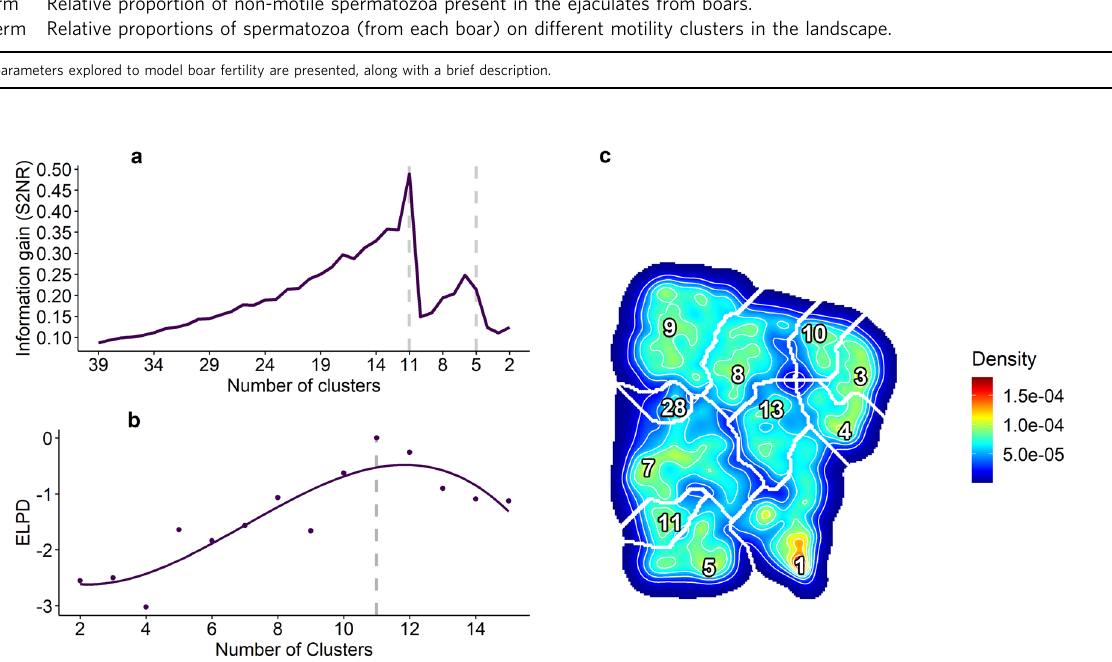
Fig. 6 Model selection based on sperm motility landscape con fi gurations. a Signal-to noise ratio (S2NR) as an heuristic of information gain, along the process of merging. The information generally increases along the merging process. However, there were some drops, that corresponded with signi fi cant changes in the hierarchical organisation of the landscape. b Leave-one out method for cross-validation, used to assess model performance (loo R package, "loo" and "loo_compare" functions, see details in Vehtari et al., 2017 79 ). The ELPD corresponds to the expected log pointwise predictive density, as a measure of predictive capability of the model. Models of different landscape con fi gurations (merging scales) were compared, 11 clusters being the best partition for model performance (ELPD = 0). c Motility landscape with 11 merged clusters that encompass the variability of the whole landscape. This represented both a good compromise between information and interpretability, and a good model